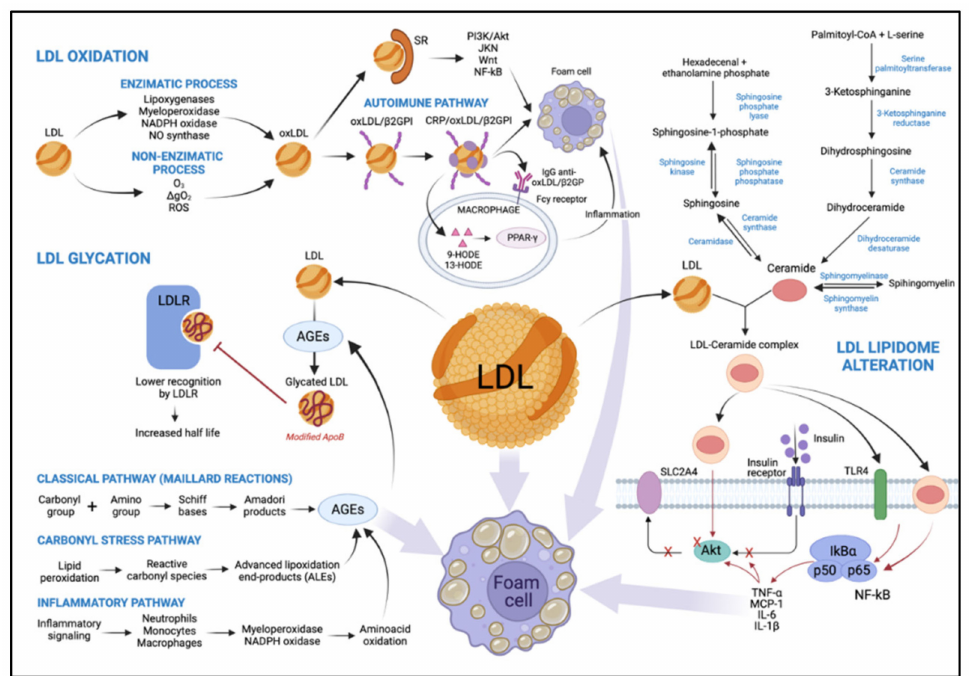
Figure 2. Representation of the main mechanisms that lead to LDL modification as a result of